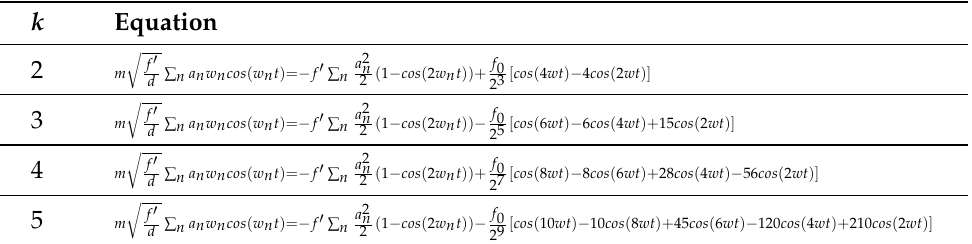
Table 2. Equations obtained for each k value.